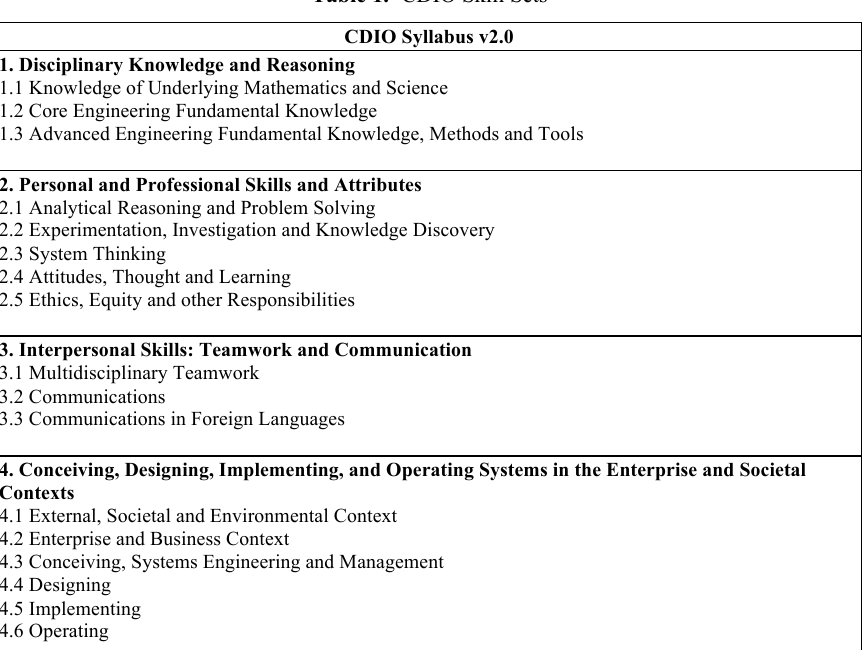
Table 1. CDIO Skill